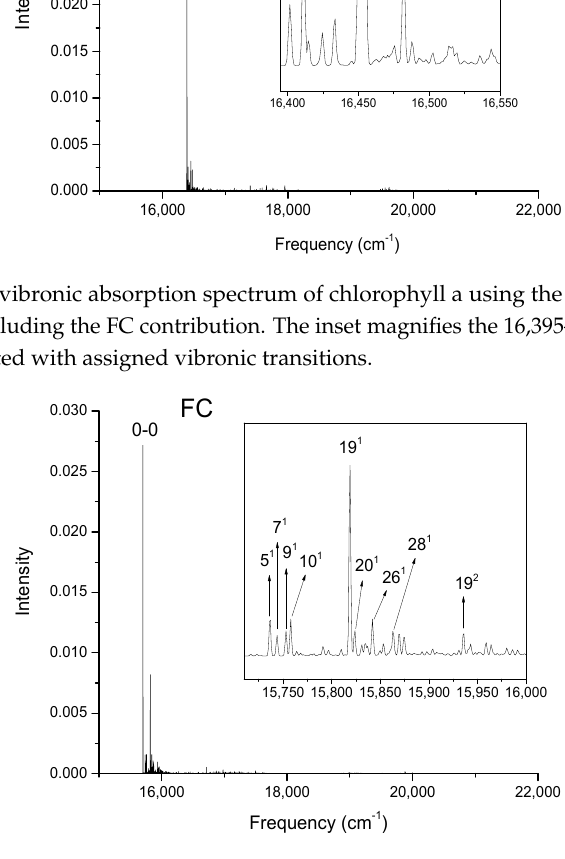
Figure 5. Calculated vibronic absorption spectrum of chlorophyll f using the B3LYP functional and 6-31G(d) basis set, including the FC contribution. The inset magnifies the 15,710–16,000 cm − 1 region of the spectrum associated with assigned vibronic transitions.